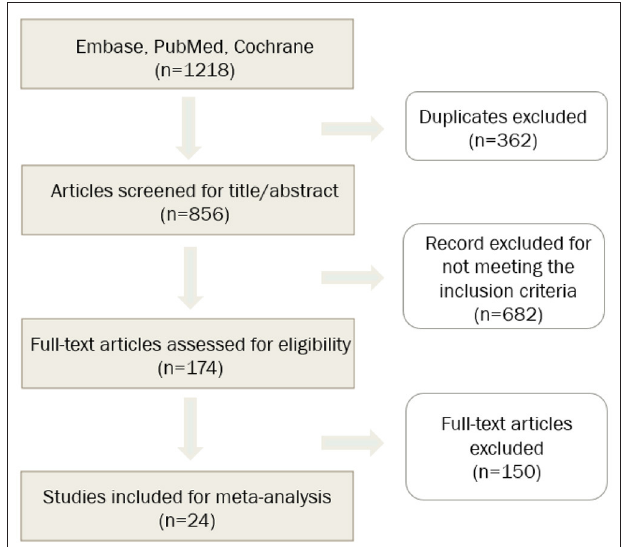
FIGURE 1 | Flowchart of study